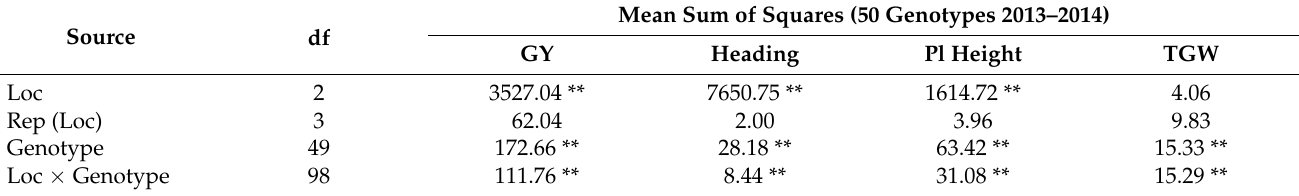
NWPZ of India under early (October) sowing conditions in 2013–2014 and 2014–2015.